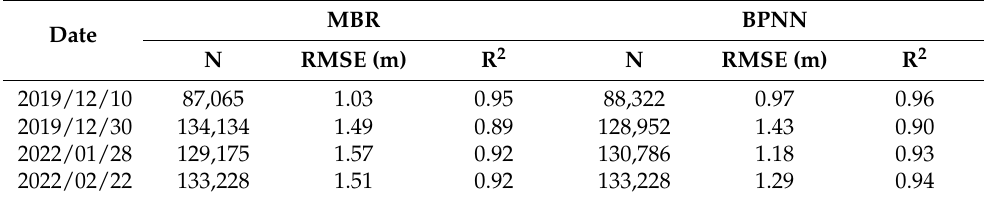
Table 3. Validation results of SDB in the Oahu